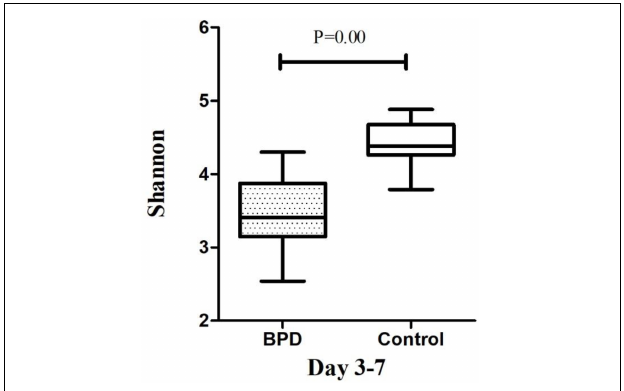
FIGURE 4 | The microbiome diversity of Shannon index between BPD group and Control group on days 3–7. Shannon index [M (P25–P75): 3.41 (3.14–3.87) vs. 4.38 (4.25–4.68), P = 0.00].